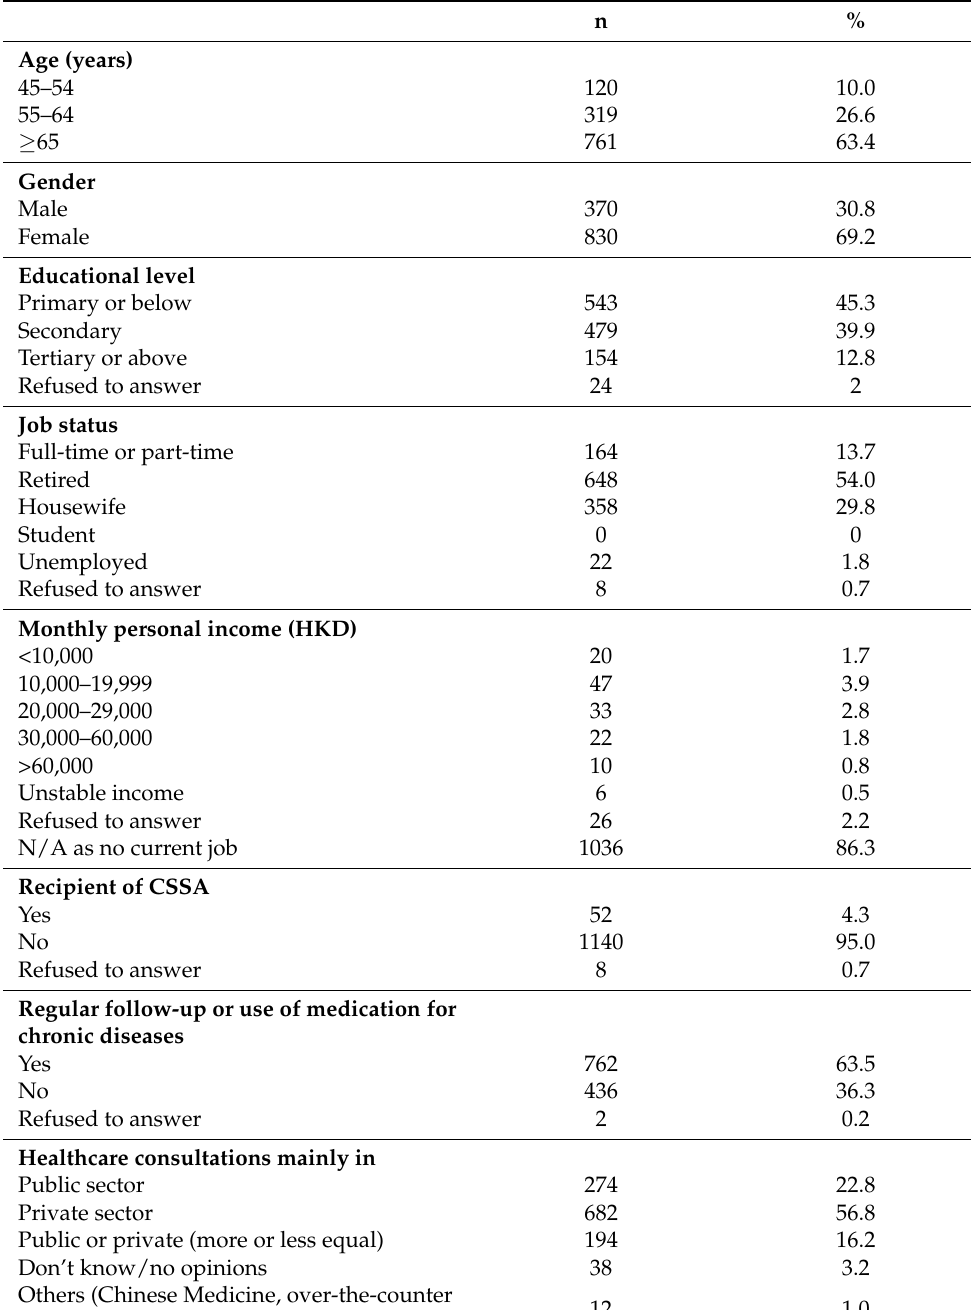
Table 1. Characteristics of the